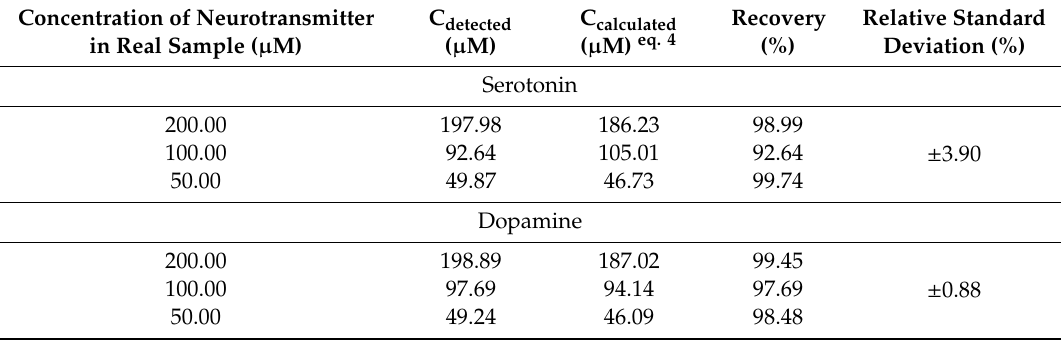
Table 5. Results obtained for 5-HT and DA determination based on the proposed methods. Concentration of Neurotransmitter